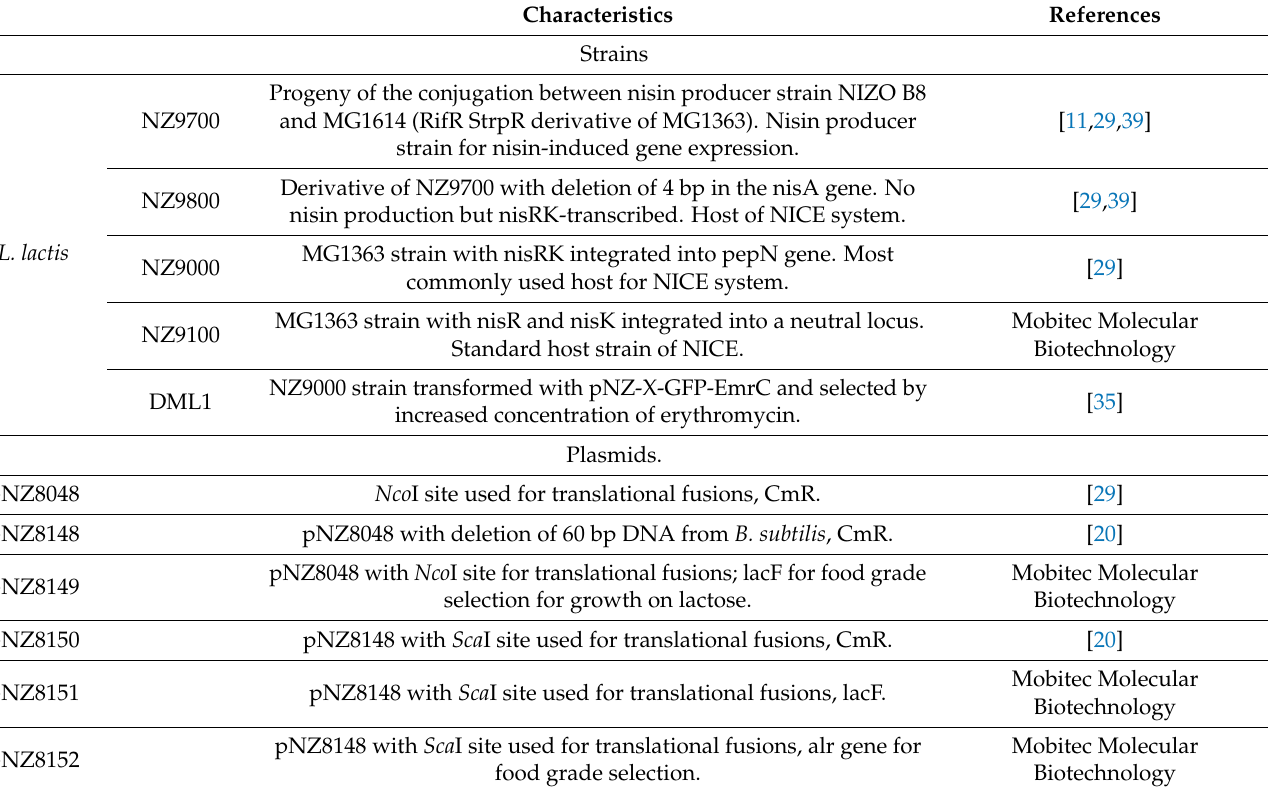
Table 1. Bacterial strains and plasmids commonly used in the NICE system for the overexpression of MPs. nisA, nisRK, genes of the nisin operon; RifR, StrpR, and CmR: resistance to rifampicine, streptomycine, and chloramphenicol, respectively.